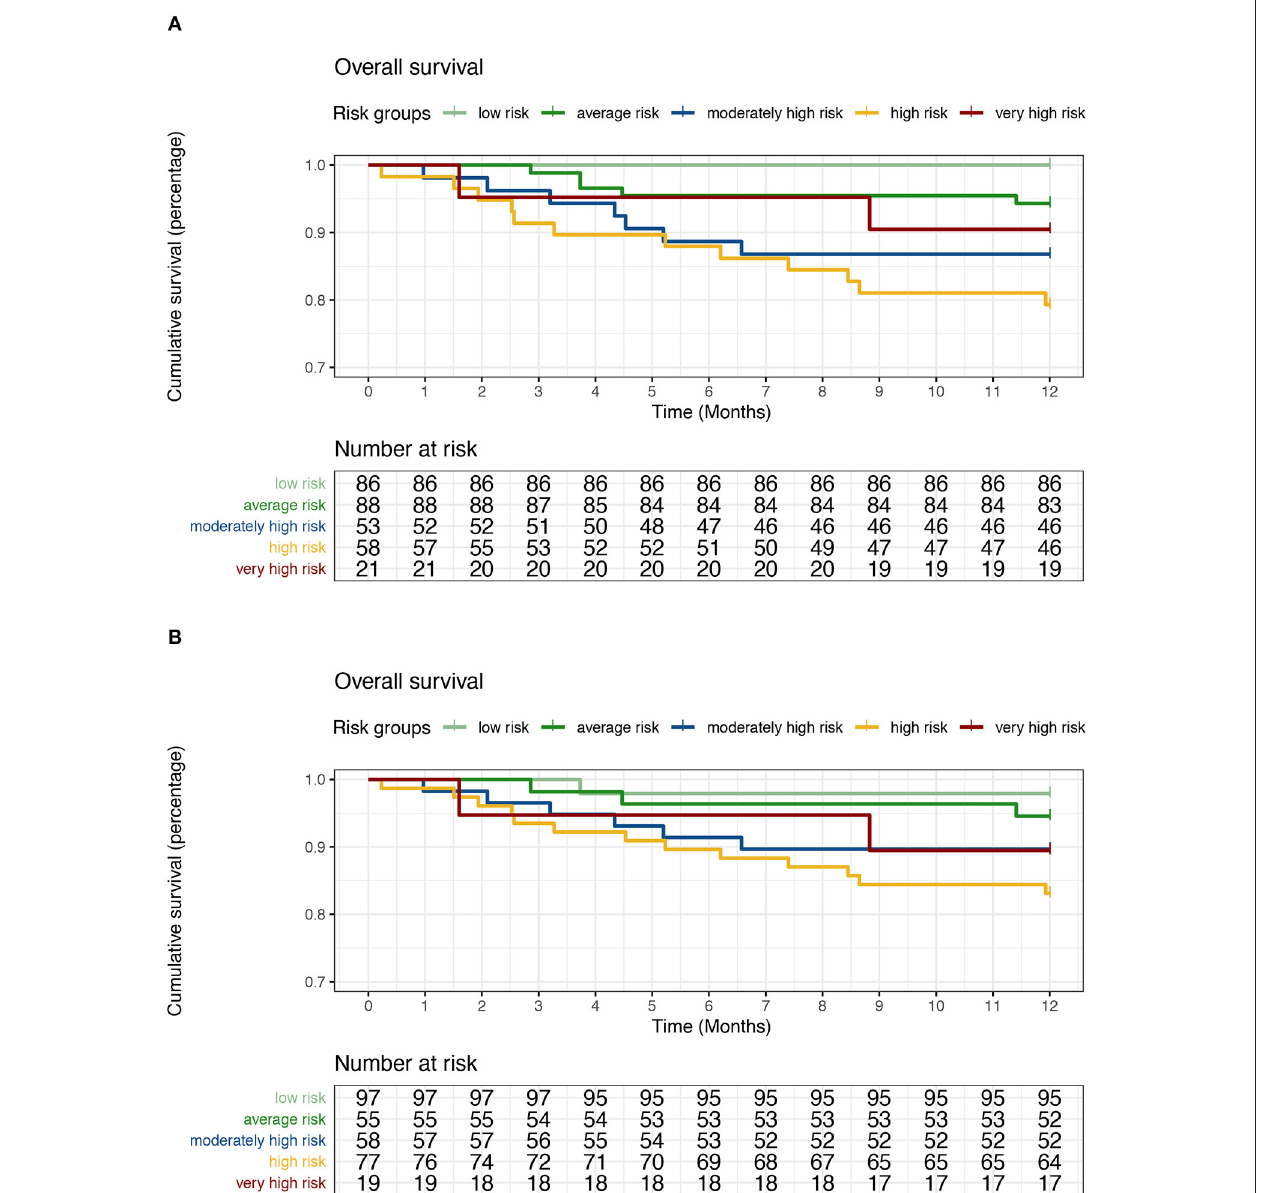
FIGURE 1 | Survival by risk group according to the prognostic equation (A) and simplified risk calculator (B) .